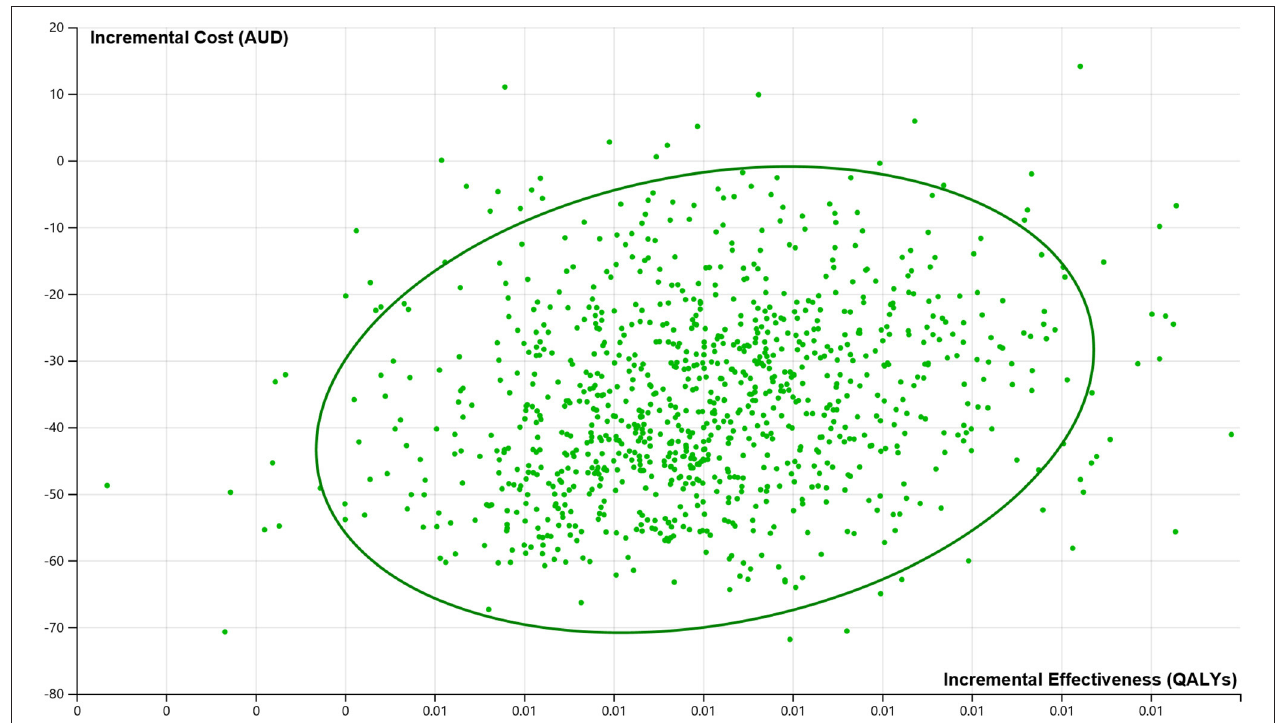
FIGURE 3 | Cost-effectiveness plane from the probabilistic sensitivity analysis indicating the probability of cost-saving and greater effectiveness from